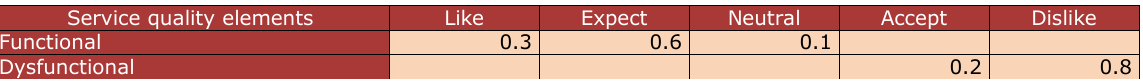
Table 3. Fuzzy Kano